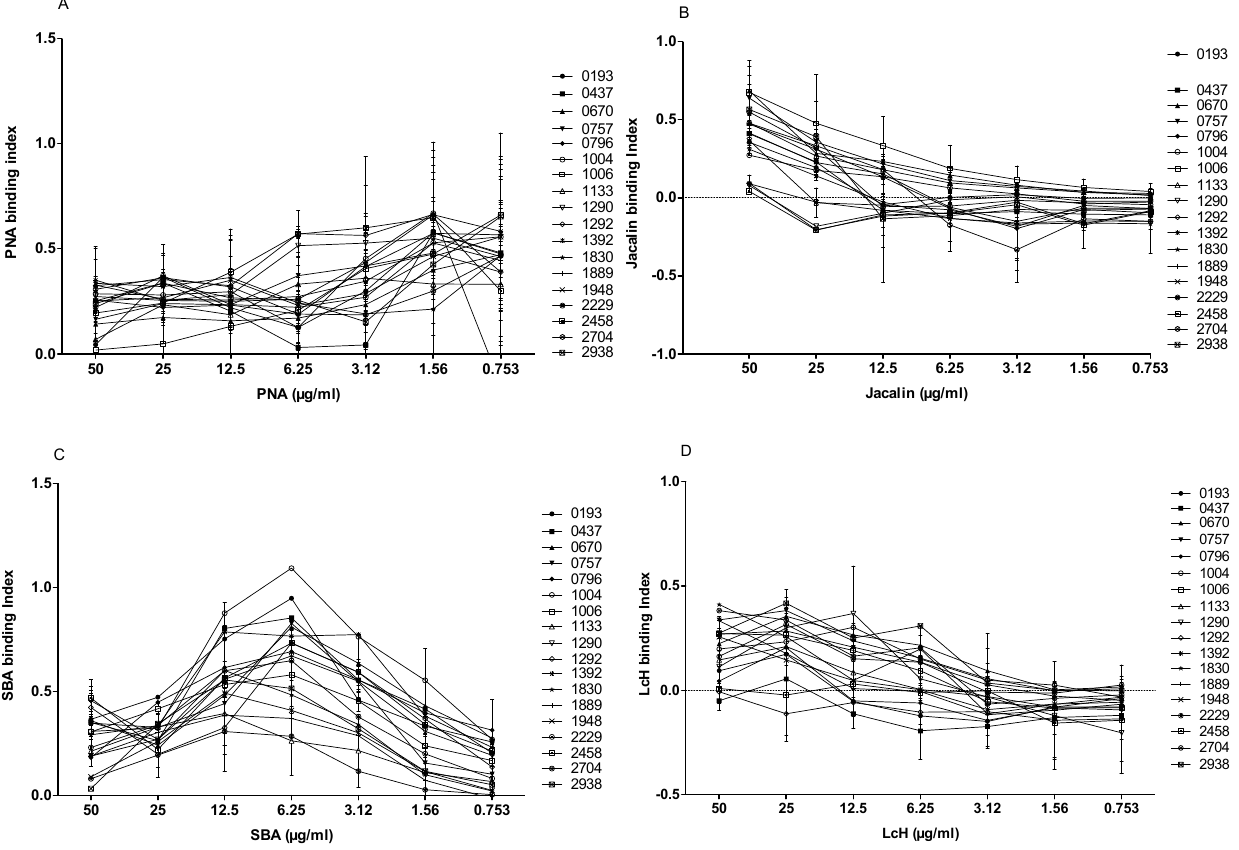
Figure 7. Binding profile of the four lectins PNA ( A ), Jacalin ( B ), SBA ( C ), and LcH ( D ) against 18 L. major isolates. The mean and the standard deviation of binding index for at least three experiments are presented for each isolate.